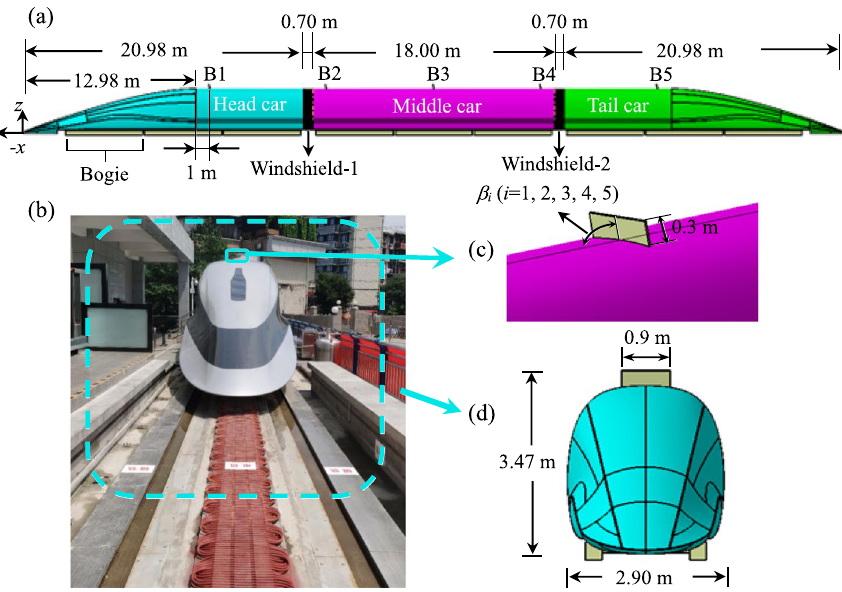
Fig. 2 The aerodynamic geometry model: ( a ) model of HTS maglev train; ( b ) vehicle prototype and test line; ( c ) parameters of the braking plate; ( d ) front